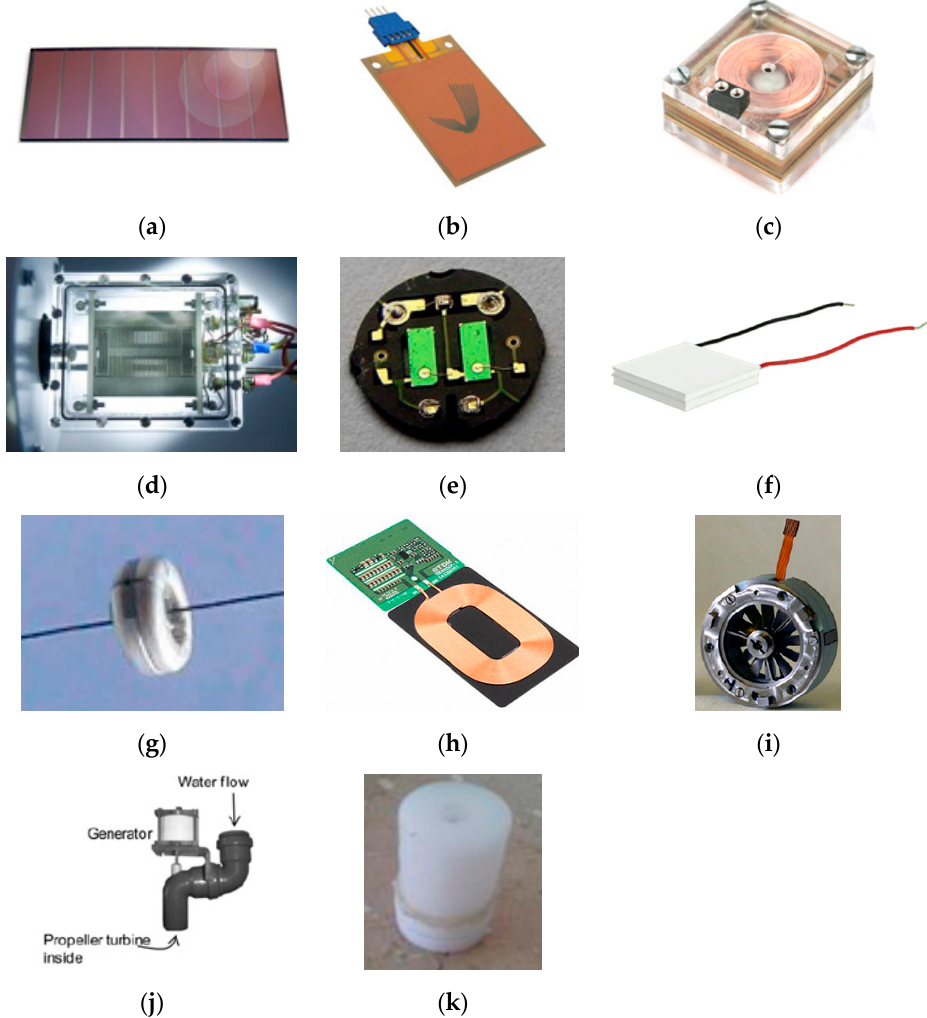
Figure 1. Energy harvesters’ technologies. ( a ) Photovoltaic; ( b ) Piezoelectic; ( c ) Electromagnetic; ( d ) Electrostatic; ( e ) Pyroelectric; ( f ) Thermoelectric; ( g ) Magnetic; ( h ) RF; ( i ) Wind flow; ( j ) Liquid flow; ( k ) Acoustic